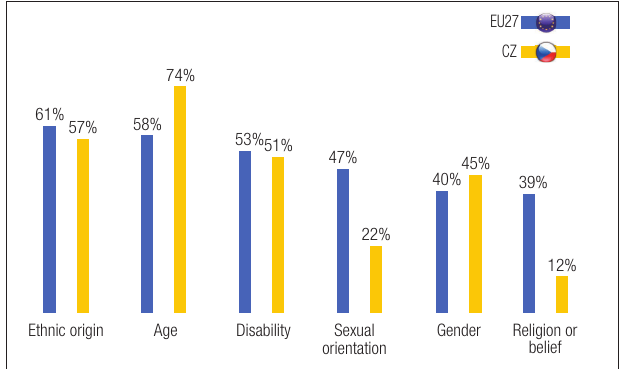
Fig. 3 - Perception and experience of discrimination in the CR and EU-27. Source: European Commission,